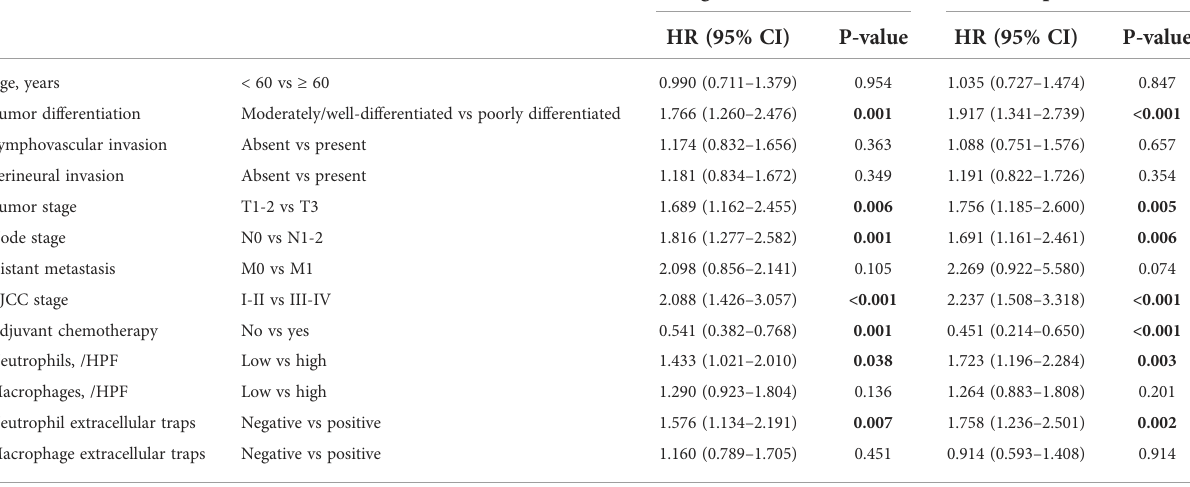
TABLE 2 Univariate analysis of factors potentially predictive of survival in patients with pancreatic ductal adenocarcinoma.